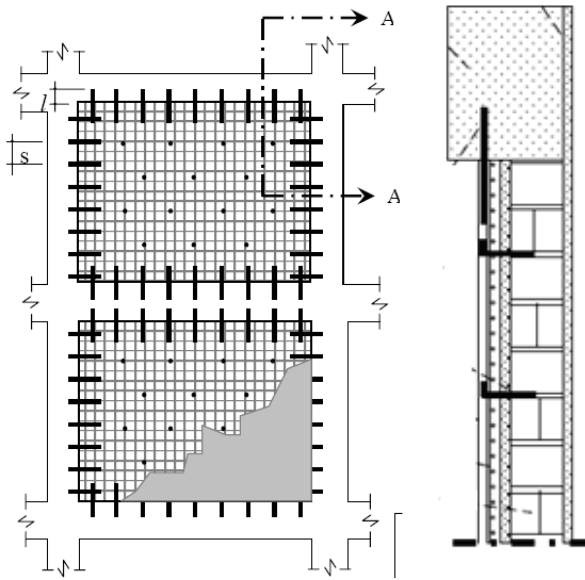
Fig. 2. Plastered walls with welded external mesh and plaster composite